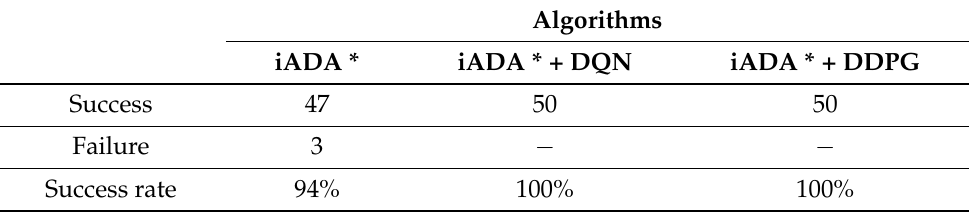
Table 1. Comparison of success rates for different approaches for 50 test cases in a static environment.